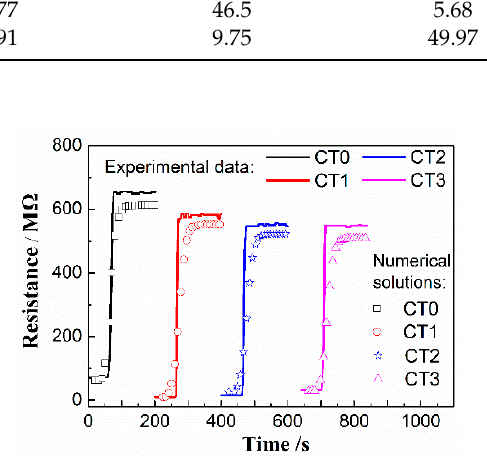
Figure 8. Concentration profiles of target gas at different radial positions of porous sensing layer. ( a ) Sample CT0; ( b ) Sample CT1; ( c ) Sample CT2; ( d ) Sample CT3. For a simplified comparison of the Th curves of samples CT0, CT1, CT2, and CT3 at the working temperature 400 °C in a chart, the same vertical scale Th / Th max was used. Figure 9a,b portrays the variations of the ratio of Th / Th max with radial coordinate under different pore structure characteristics